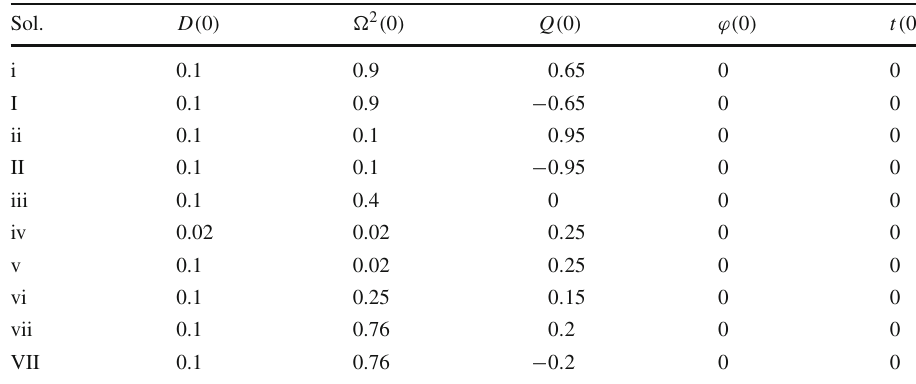
Table 4 Here we show ten initial data sets for the simulation of full system (118) and time-averaged system (145) for γ (cid:7)= 1 and of system (151) for γ = 1, for the FLRW metric with positive curvature ( k = + 1). All the conditions